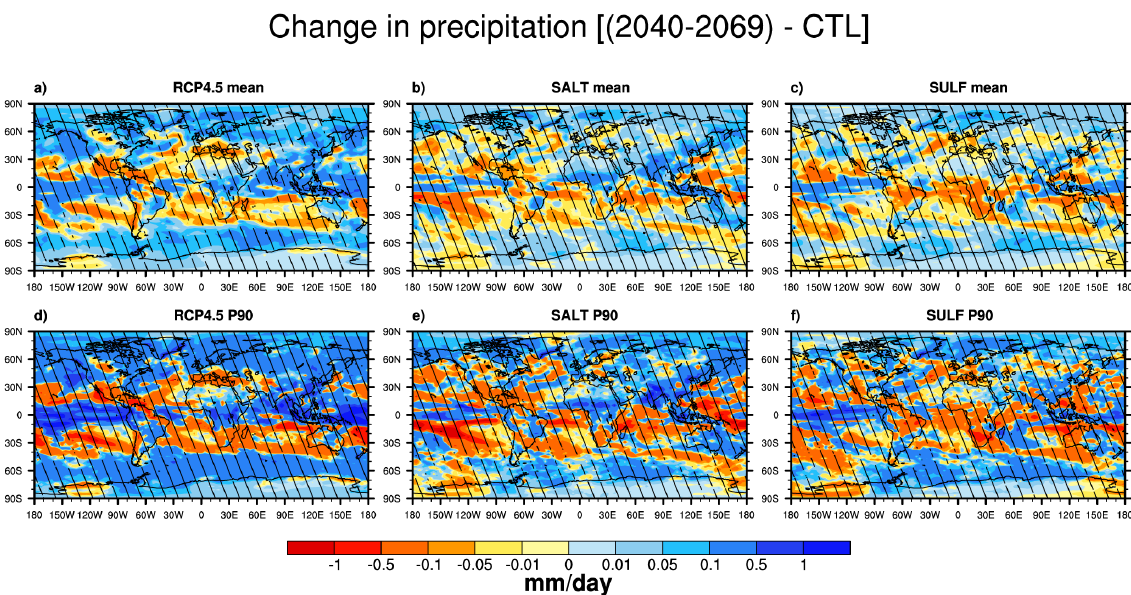
Figure 2. Multi-model mean change in precipitation (mmday − 1 ) for RCP4.5 (left column), SALT (middle) and SULF (right column) for the 2040–2069 period minus the RCP4.5 2006–2035 control period (CTL). Panels (a) to (c) denote changes in mean values, (d) to (f) same as (a) to (c) but for the 90th percentile of the temporal distribution at each model grid point. Hatches denote regions where the changes are 95% statistically